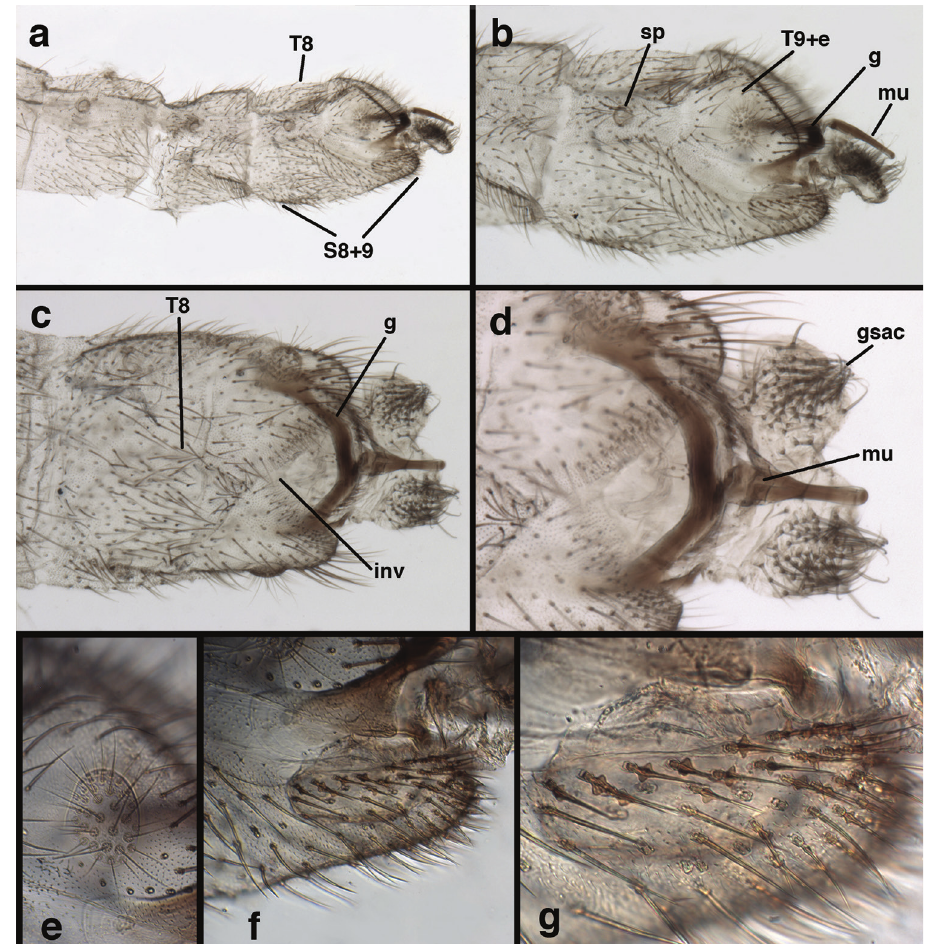
Figure 121. Chrysopa confraterna Banks: Male abdomen and genitalia, ( a ) segments A6-terminus, lat- eral ( b ) terminalia, lateral ( c ) terminalia, dorsal, gonarcus partially extruded posteriorly ( d ) terminus of T9+ectoproct, gonarcal complex ( e ) callus cerci ( f ) sternite 9 [Note demarcation between S8 and S9.] ( g ) sternite 9, lateral, with large, flanged setae. g gonarcus gsac gonosaccus inv distal invagination of dor- sal T9+e mu mediuncus sp spiracle S8+9 fused eighth and ninth sternites T8 eighth tergite T9+e fused ninth tergite + ectoproct (Argentina, Mendoza, Chacras de Coria, holotype, MCZ). synonymy. The C. binaria type shares external and internal features, especially patterns of wing venation and coloration, head and body markings, with those of U. confraterna females. Also, we found nothing notable in the female abdomen or genitalia that would differentiate the